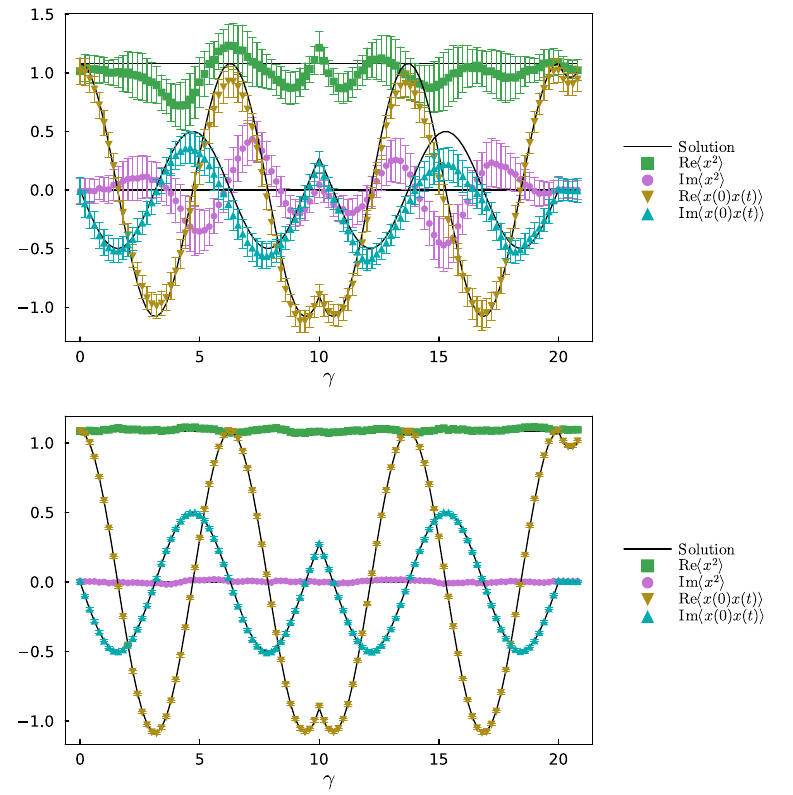
Figure 3 . The result of a complex Langevin simulation of the real time harmonic oscillator without a kernel (top) and with a kernel (bottom) for the observables h x 2 i , and the correlator h x (0) x ( t ) i . Simulations are carried out with 100 trajectories and up to mτ every m ∆ = 0 . 1 using the implicit scheme Euler-Maruyama with θ = 1 . 0 with adaptive step-size τ L with tolerance 10 − 3 (top) and the explicit scheme Euler-Maruyama with θ = 0 with fixed step-size ∆ τ = 10 − 3 (bottom). Values of the correlators from the solution of the Schrödinger equation are L given as solid black